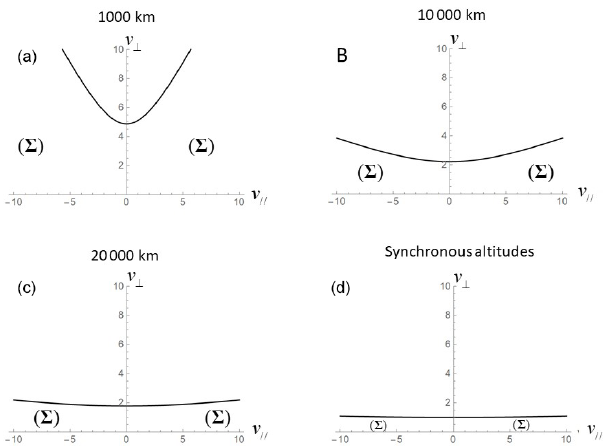
Figure 3. Same as Fig. 2, but parallel potential behaved as poten- tial barriers: (a) electrons (ions) at 1000km for parallel potentials of − 10V (10V), (b) electrons (ions) at 10000km for − 50V (50V), (c) electrons (ions) at 20000km for − 200V (200V), and (d) elec- trons (ions) at geosynchronous altitudes for − 500V